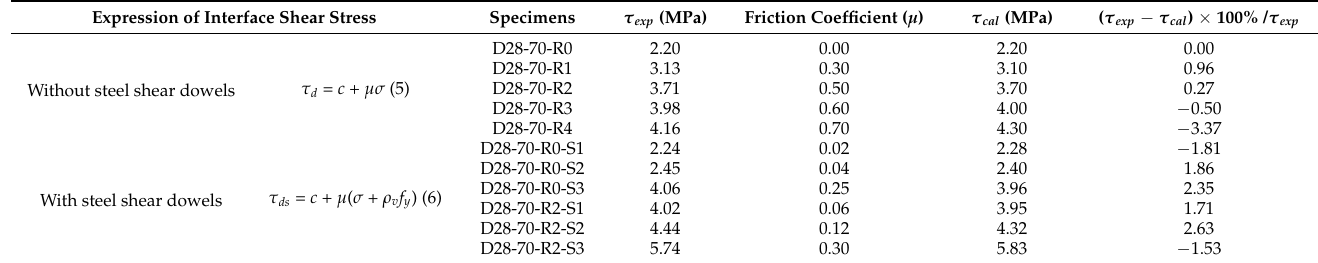
Table 7. Summary of test results according to the CEB-FIB Model 2010.